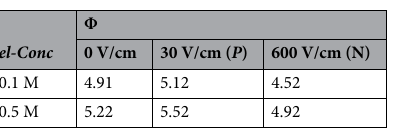
Table 2. Variation of Φ with E at different el - Conc